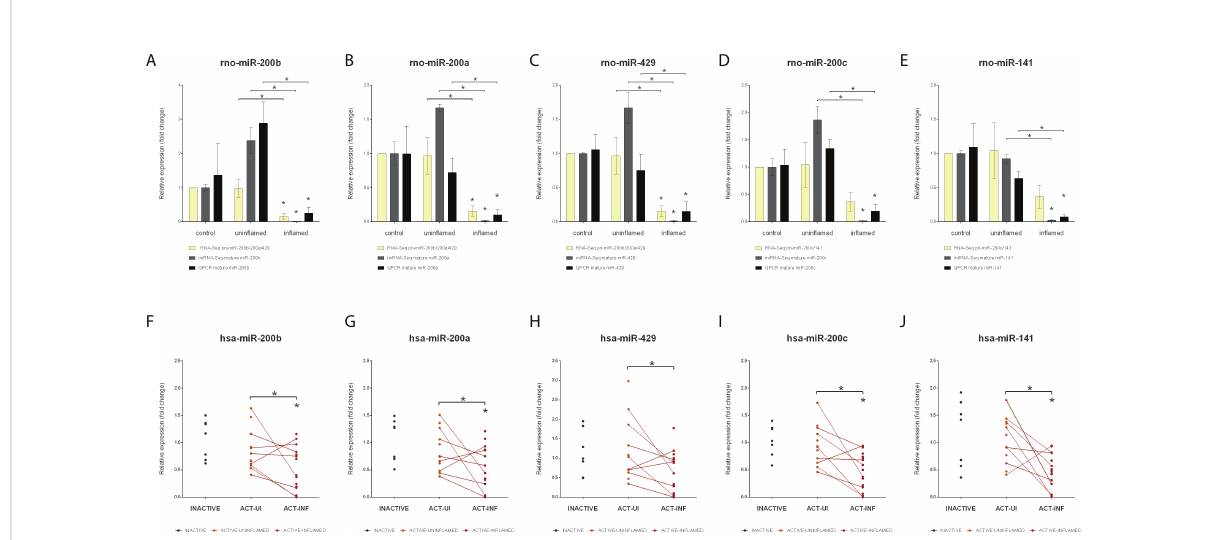
FIGURE 3 Decreased expression of the miR-200 family members in in fl amed colons. Relative expressions of pri-miR-200b/200c/429 and mature miR-200b (A) , miR-200a (B) , miR-429 (C) , and pri-miR-200c/141 and mature miR-200c (D) and miR-141 (E) are shown from control (left columns), unin fl amed (middle columns) and in fl amed (right columns) rat colon sections; yellow, gray and black columns represent RNA-Seq (pri-miRNA), miRNA-Seq (mature miRNA) and QPCR (mature miRNA) data, respectively. Data are presented as the mean ± SEM; * p <0.05. In the bottom (F – J) panels expression changes of the same microRNAs are shown from inactive (left), active unin fl amed (middle) and active in fl amed (right) colon samples of IBD patients. Dots represent individual values, the lines connect unin fl amed and in fl amed samples from the same IBD patient; * p